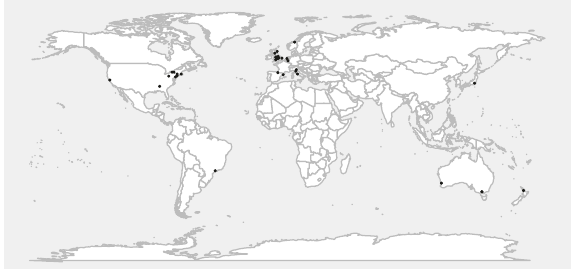
Figure 2: Distribution of reported Intermediate Care Units around theworld.ThisworldmapdemonstratesthelocationofIntermediate Care Units as reported by our included studies. Most reported Intermediate Care Units are situated in Europe and around the east coast of the United